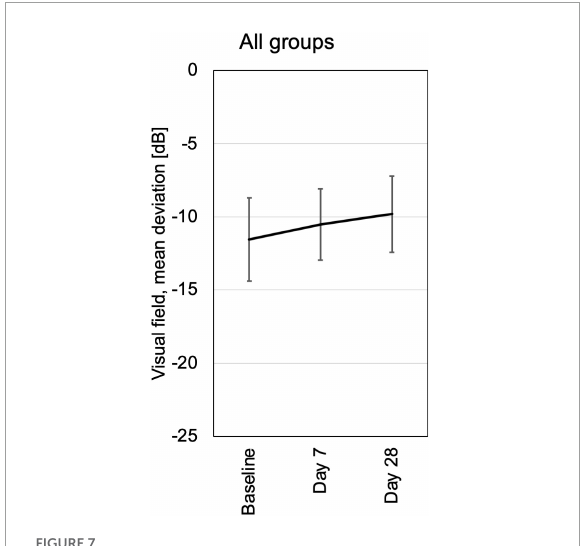
FIGURE7 Visual field testing was performed at baseline, days 7 and 28. Mean deviation from normal is shown for each visit of all patients pooled from the three different dosing groups. All patients had loss of visual field sensitivity at baseline due to pre-existing destruction of previous chronic uveitis. In the follow up were no additional losses of more the 2 dB in a single patient. At day 28 the average visual field sensitivity had increased slightly, probably in part by training